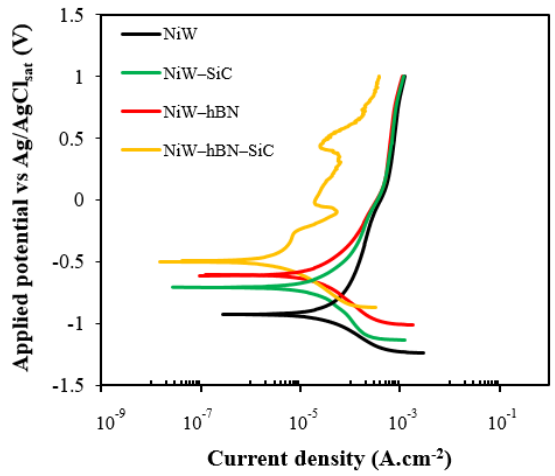
Figure 7. SEM micrograph ( a ), EDS spectra ( b ), and X-ray mapping ( c ) taken from the surface of the NiW–SiC–hBN coating; EDS spectra and EDS map of the area are highlighted with white rectangles in the SEM images.